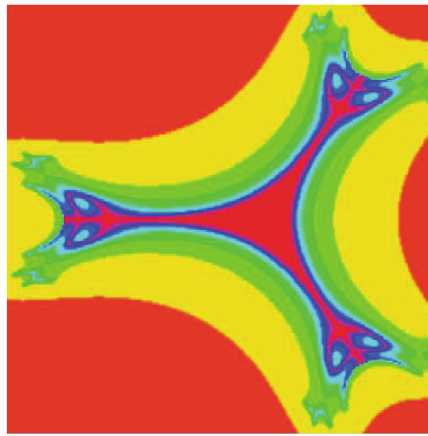
Figure 9: Relative superior multicorn for 𝑠 = 0.2 and 𝑠 󸀠 = 0.6